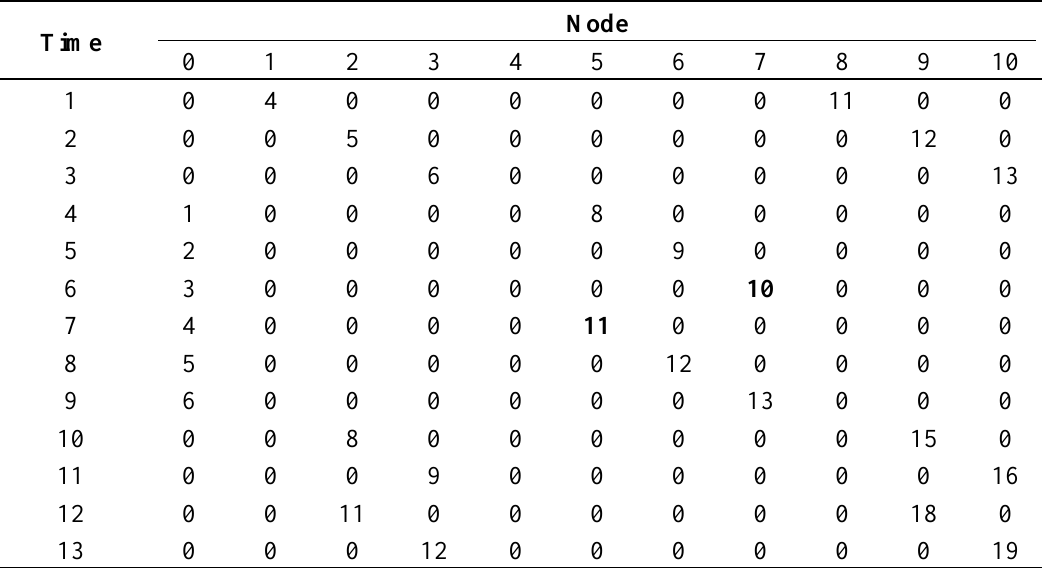
Table 4. Time schedule with ADJUST − (1) when n = 10, p =